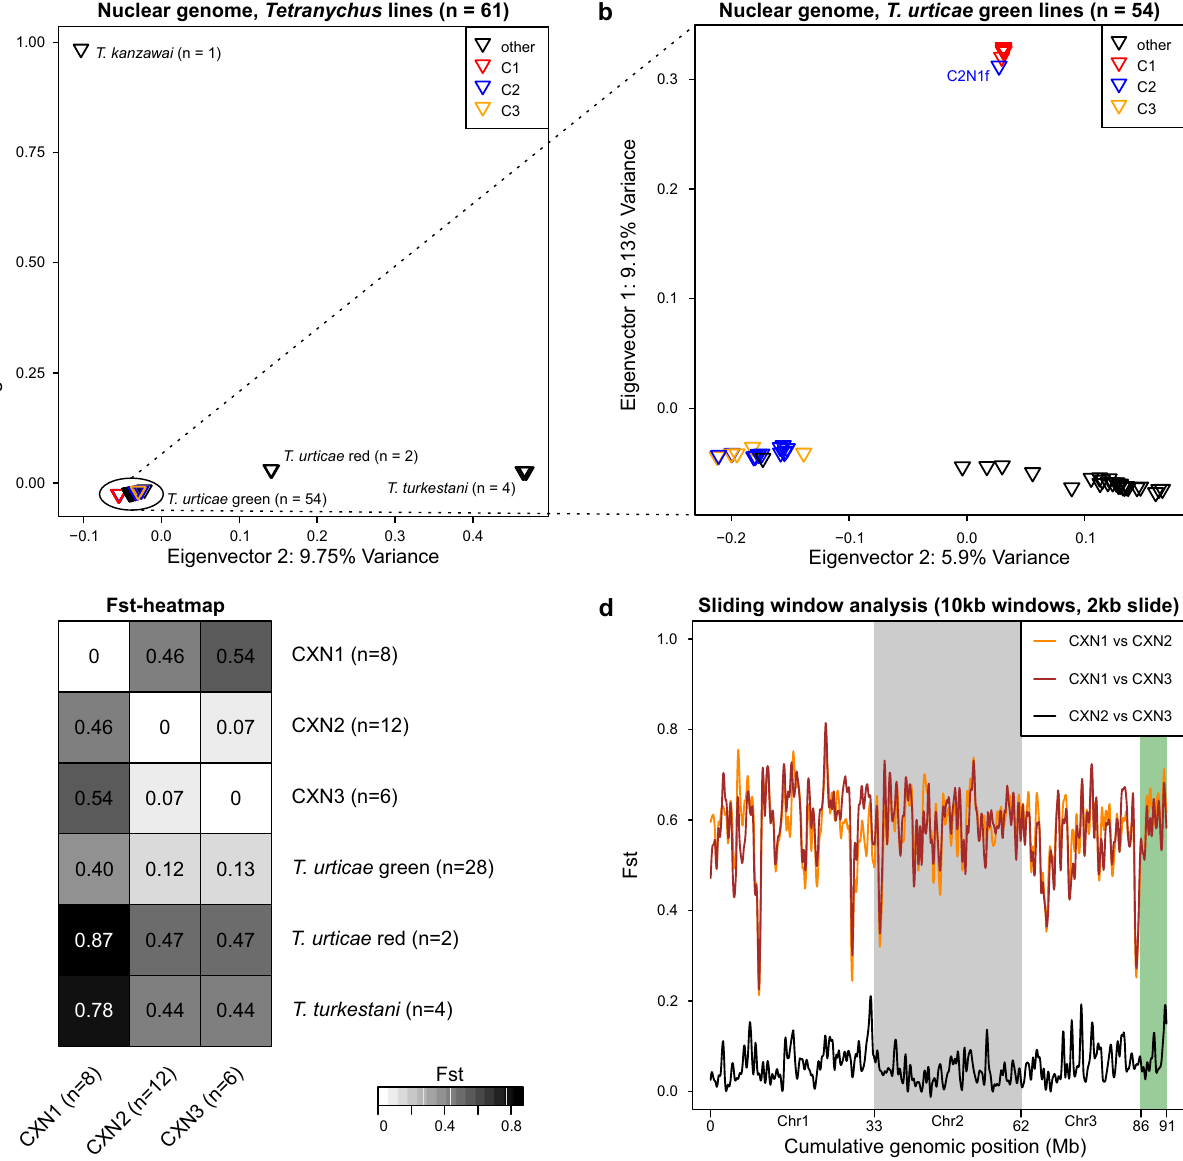
Fig. 3 Extent of genetic divergence between Tetranychus species and among Tetranychus urticae lines. Genetic differentiation between 26 iso-female Tetranychus urticae (green) lines (this study), 30 additional T. urticae lines (28 green and 2 red lines, denoted as ‘ other ’ and green or red as indicated) and two other Tetranychus species ( T. turkestani and T. kanzawai ) as assessed by principal component analyses ( a , b ), as well as by c pairwise genome-wide Fst calculations (the extent of shading re fl ects Fst levels as indicated, bottom right). For b genetic differentiation assessed by a principal component analysis, but limited to T. urticae green lines (see dashed lines connecting to a ), is shown. d Genetic differentiation among the 26 iso-female green lines (this study) as assessed in a sliding window Fst analysis across the T. urticae genome (the three scaffolded chromosomes are as indicated with alternative shading; unplaced and concatenated scaffolds are shaded green, far